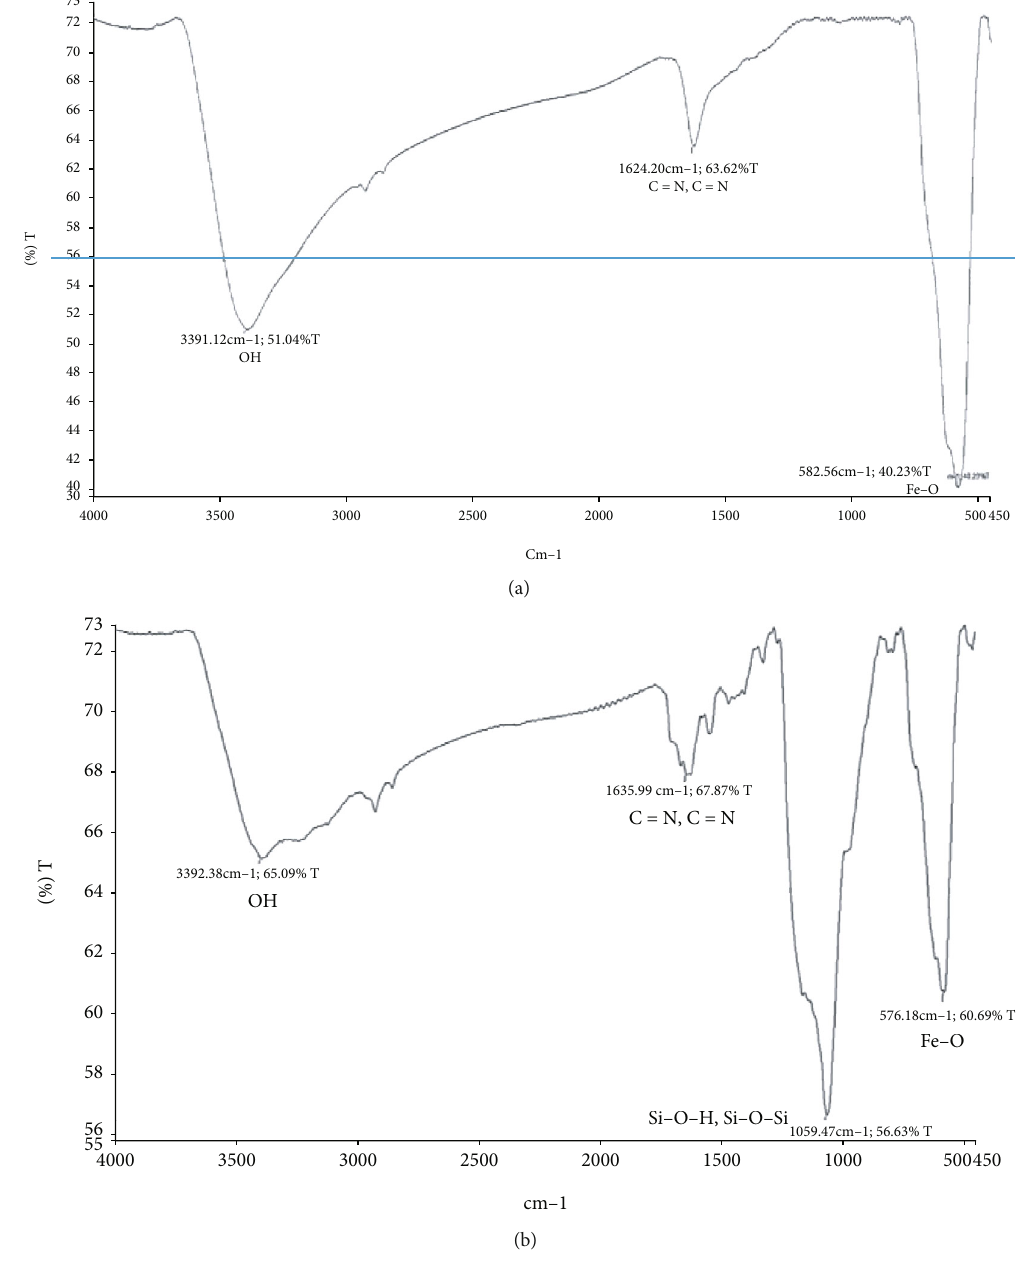
O and (b) Fe O 3 4 3 4